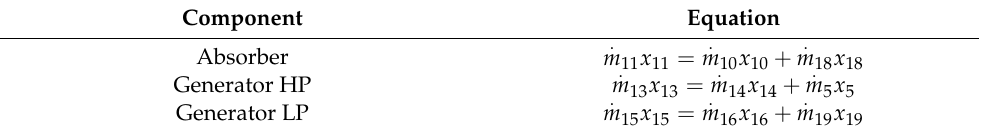
Table 4. Species balance for the